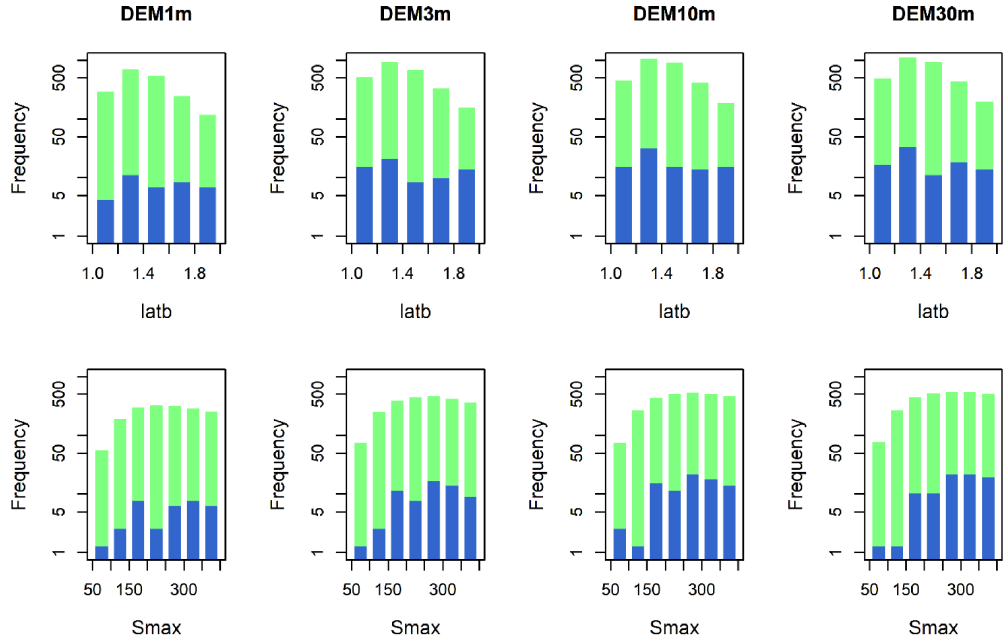
Figure 9. Distribution of good parameters for streamflow (in green) and for both streamflow and saturated areas (in blue) with log y axis in four SWAT-HS setups using different DEM